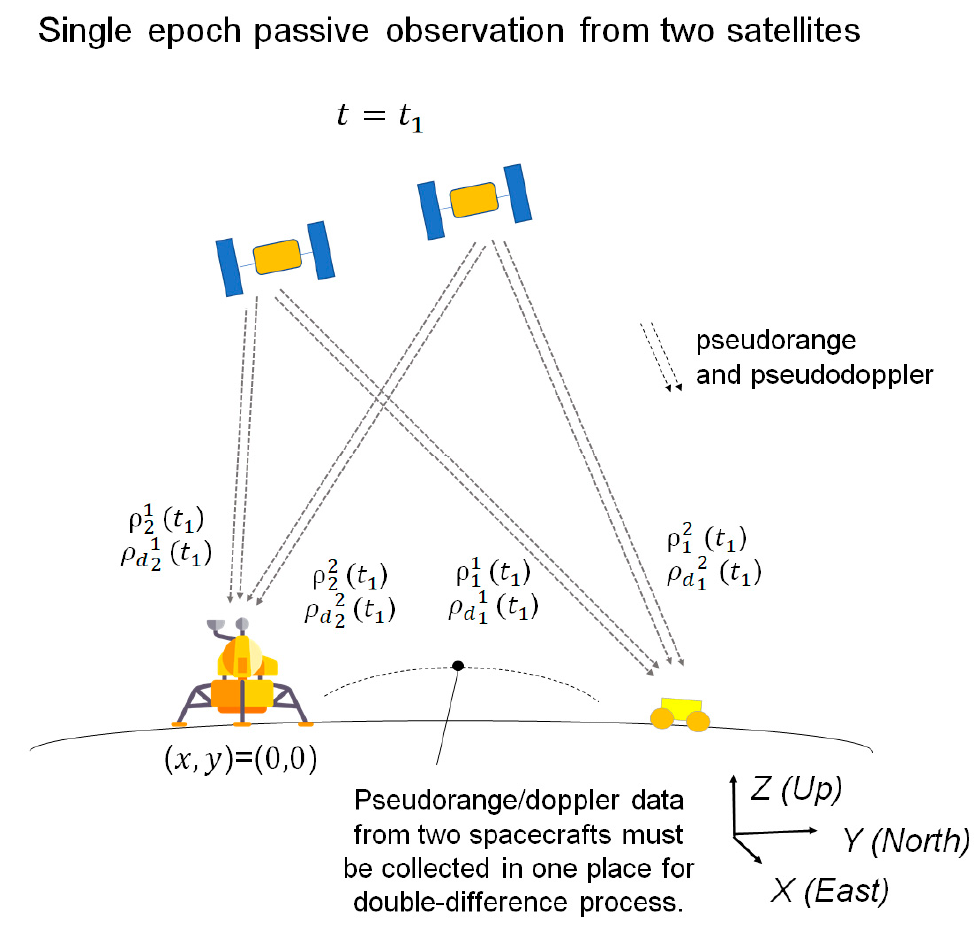
Figure 2. Overview of the double-differenced TOA–FOA method.